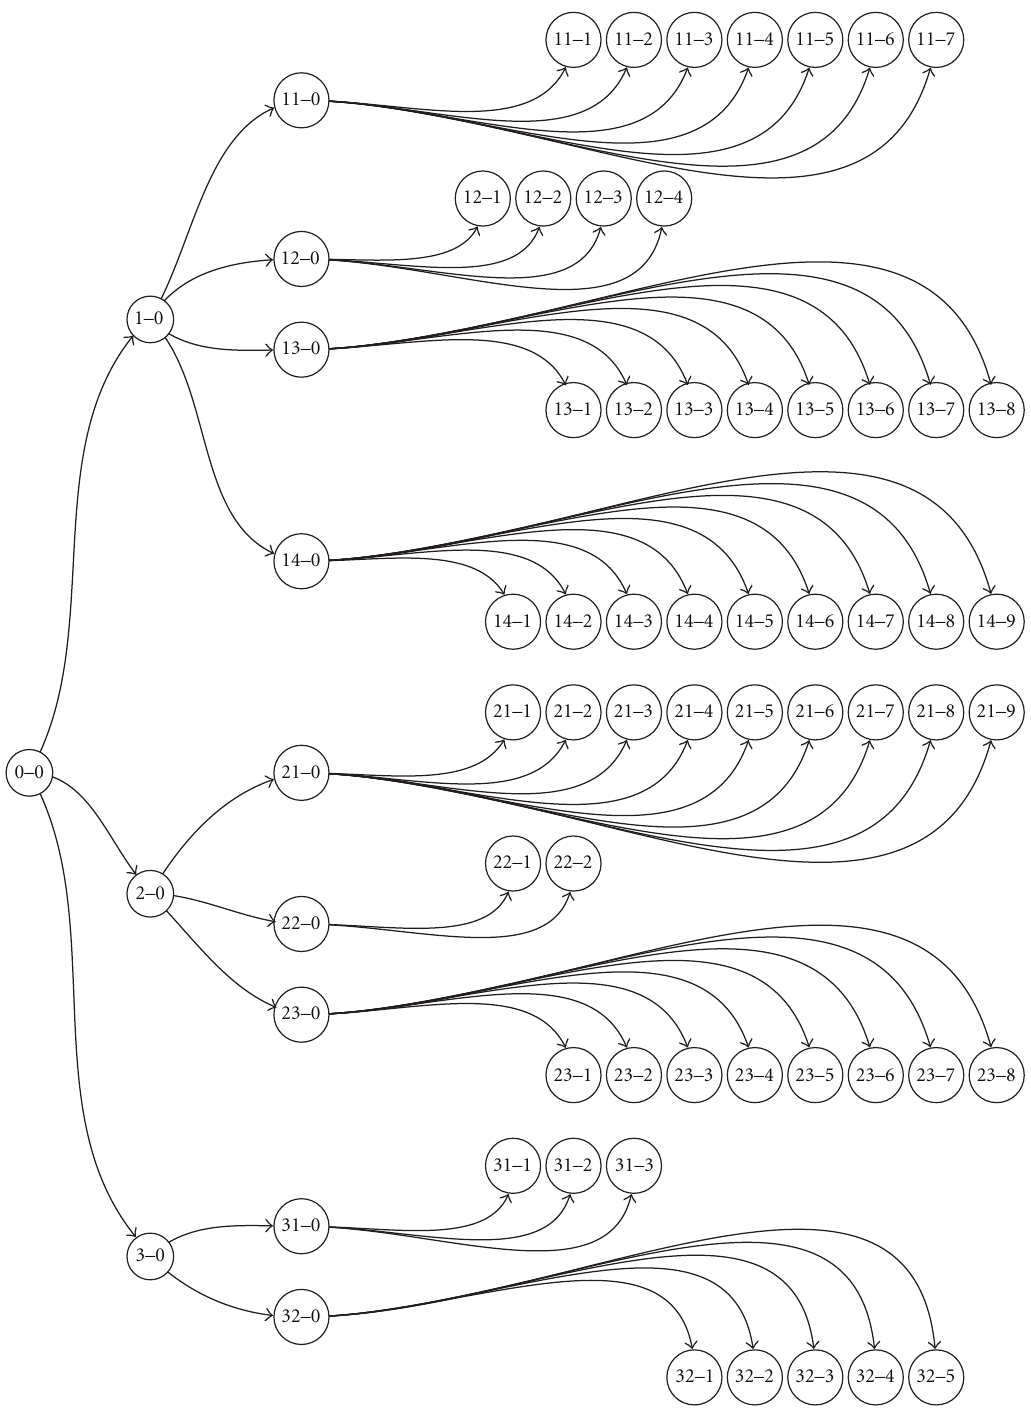
Figure 9: Problem